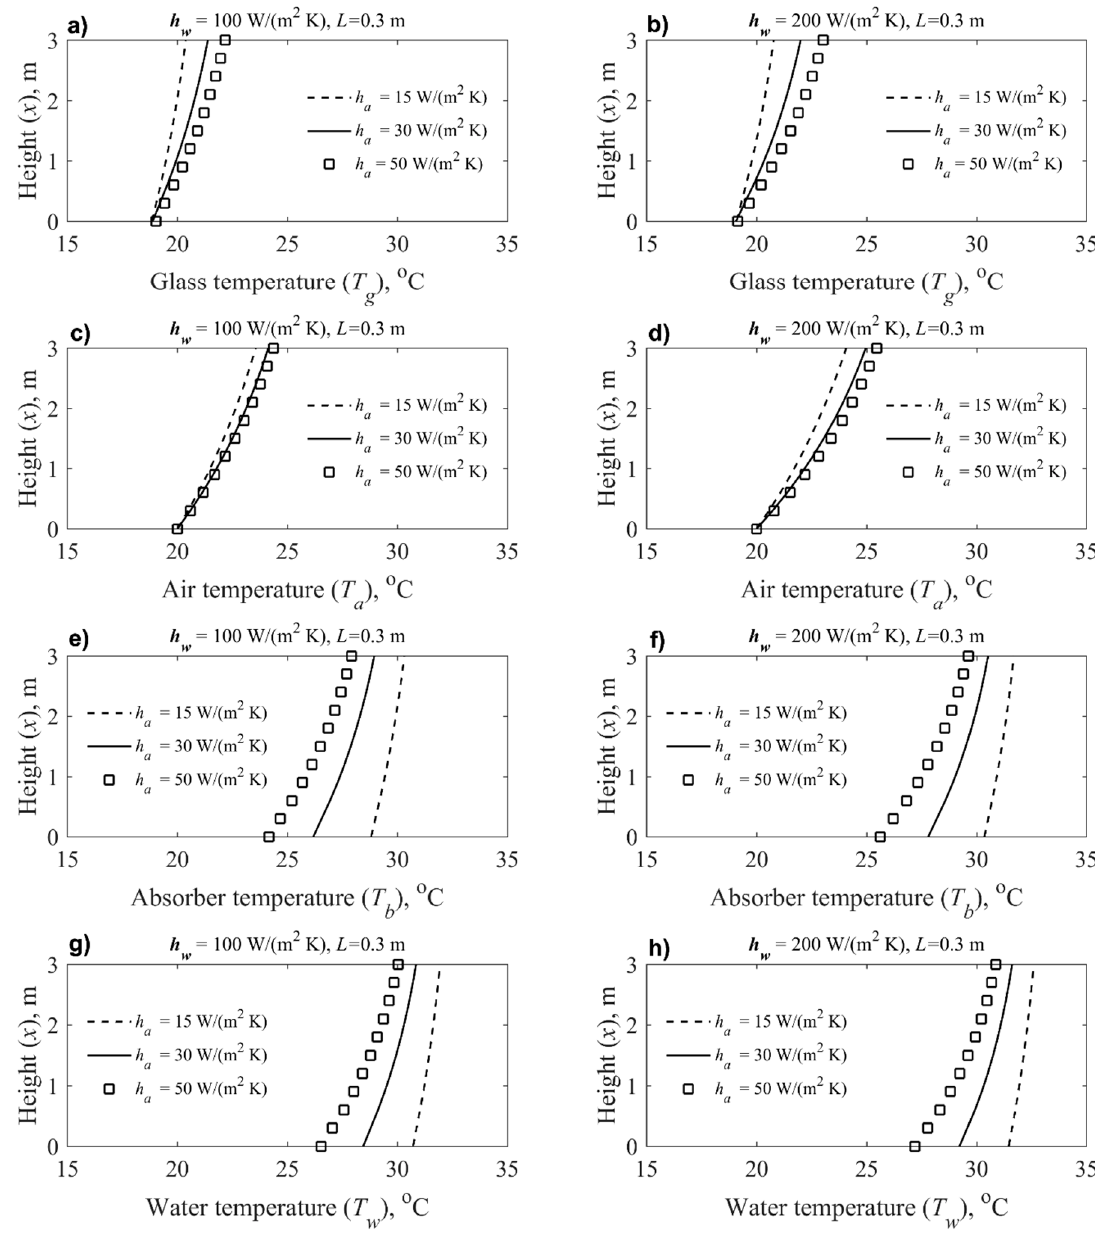
Figure 8. The temperature variations of the different elements of the system: ( a , b ) glass temperature; ( c , d ) air temperature; ( e , f ) absorber temperature; ( g , h ) water temperature as a function of the system height for the tank of 0.3 m in width, after 10 h. Subfigures ( a , c , e and g ) are obtained for h w = 100 W/(m 2 ·K) while ( b , d , f , and h ) for h w = 100 W/(m 2 ·K).